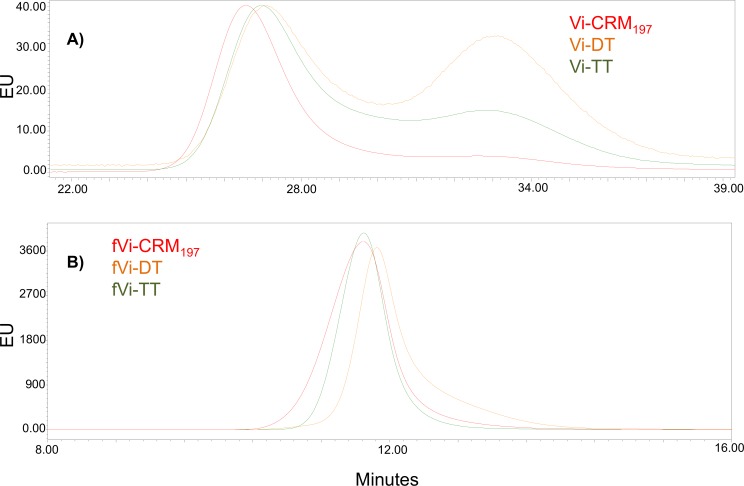
A) HPLC-SEC profiles (fluorescence emission detection) of Vi-CRM197 (red), Vi-DT (orange) and Vi-TT (green). TSK gel 6000–5000 PW columns, NaCl 0.1 M NaH2PO4 0.1 M ACN 5%, pH 7.2; flow 0.5 mL/min; Vtot 49.004 min; V0 24.382 min. B). HPLC-SEC profiles of fVi-CRM197 (red), fVi-DT (orange), fVi-TT (green). TSK gel 3000 PWxl column; NaCl 0.1 M NaH2PO4 0.1 M ACN 5%, pH 7.2; flow rate 0.5 mL/min; Vtot 23.326 min, V0 10.663 min.